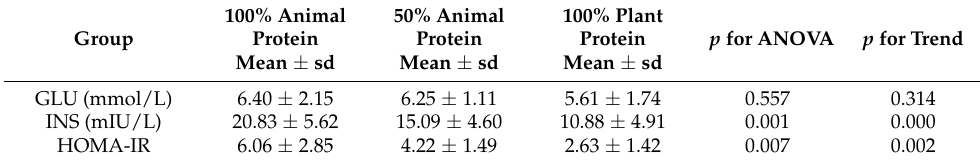
Table 6. GLU, INS, and HOMA-IR levels in rats administered different proportions of protein.